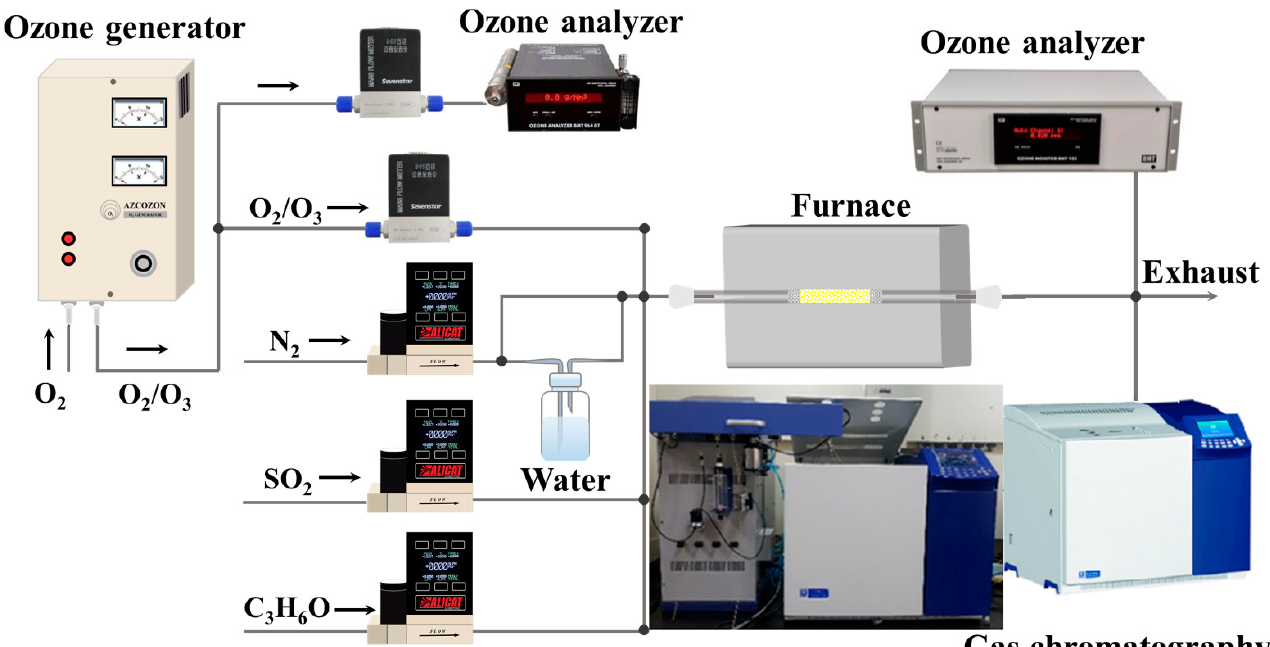
Figure 9. Experimental setup schematic.